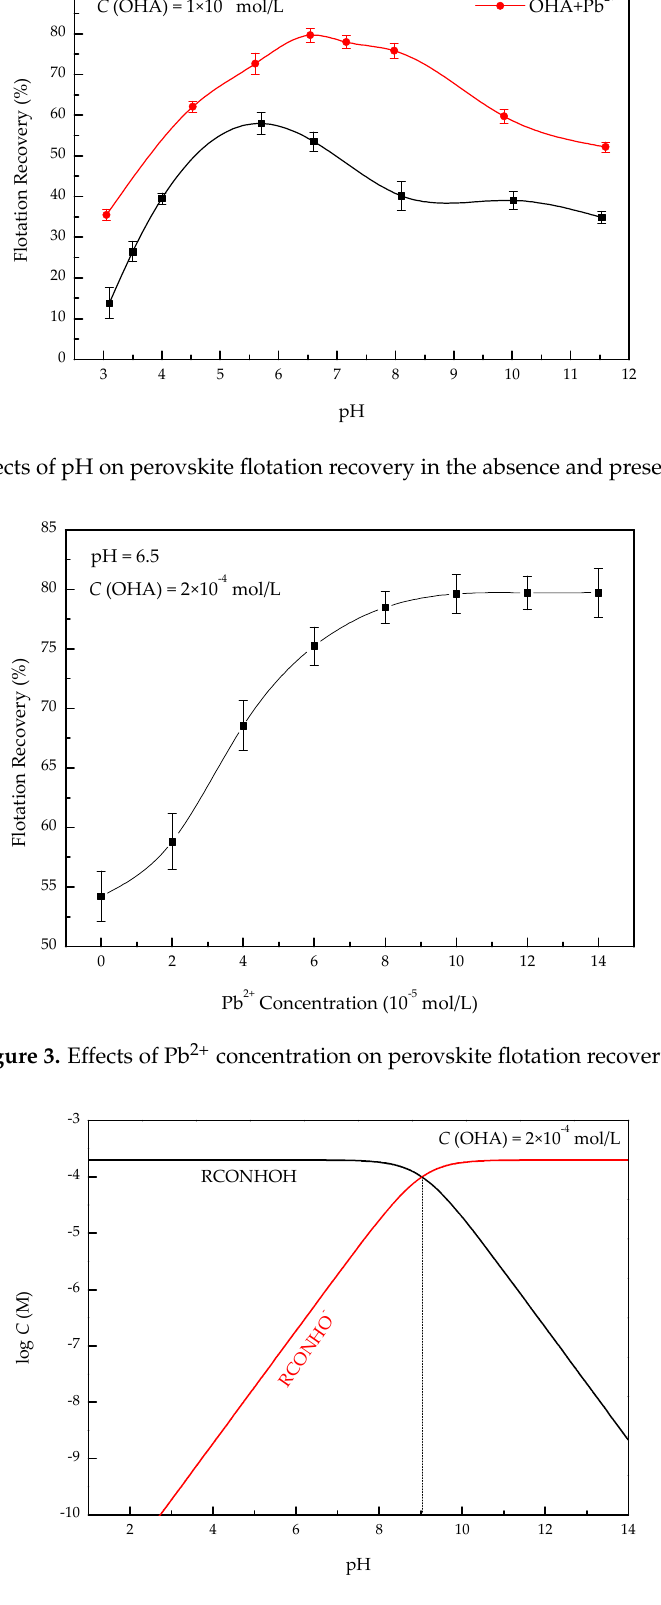
Figure 4. Logarithmic diagram of octyl hydroxamic acid (OHA) hydrolysis components.